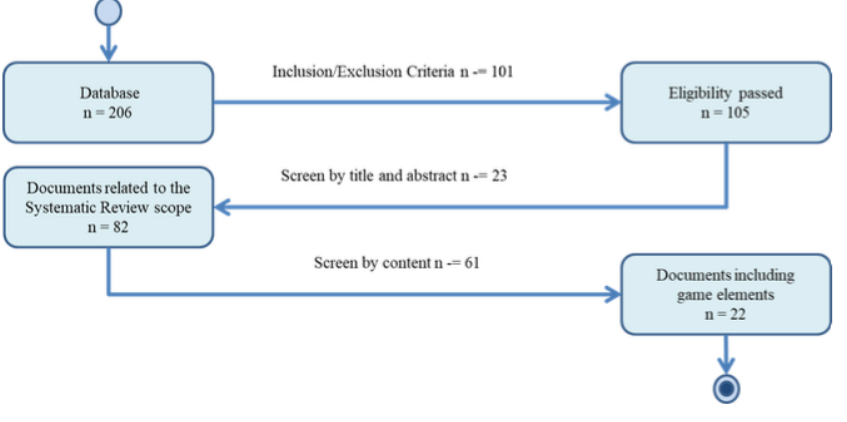
Figure 1. Flow diagram of the systematic review